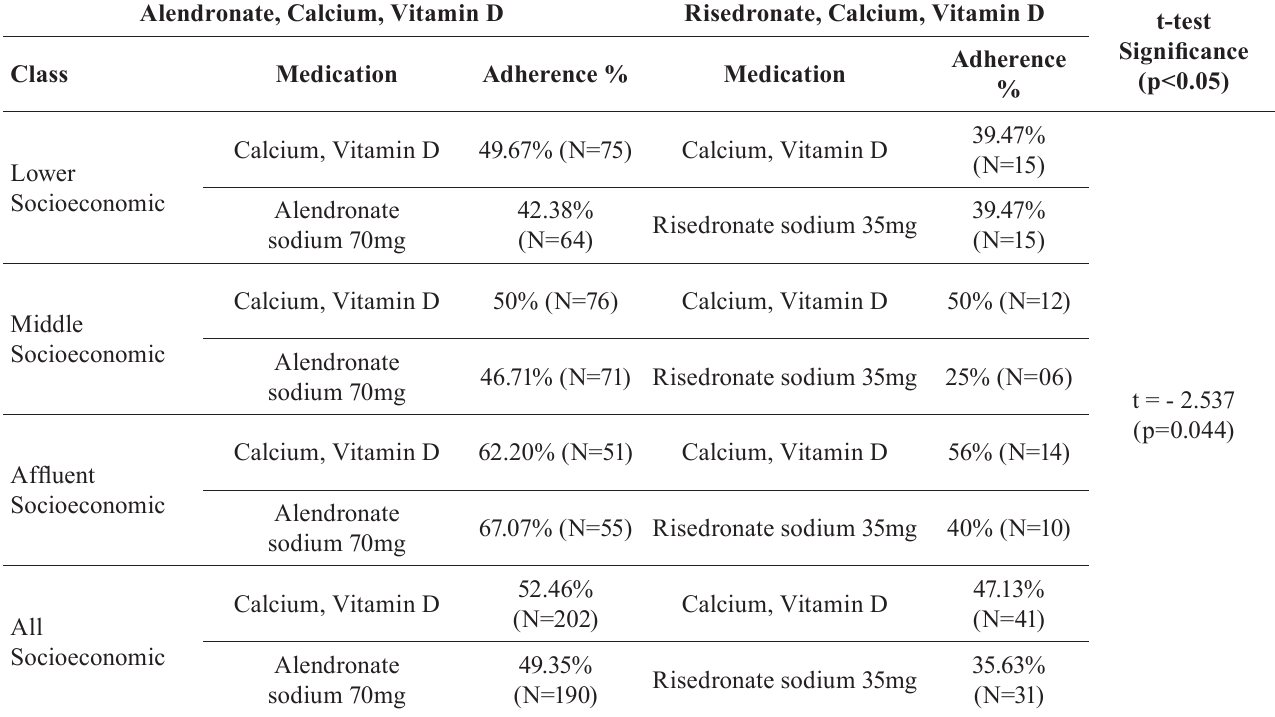
TABLE VI - Medication Adherence with Riserdronate, Alendronate, Calcium, Vitamin D in different Socioeconomic Classes Alendronate, Calcium, Vitamin D Risedronate, Calcium, Vitamin